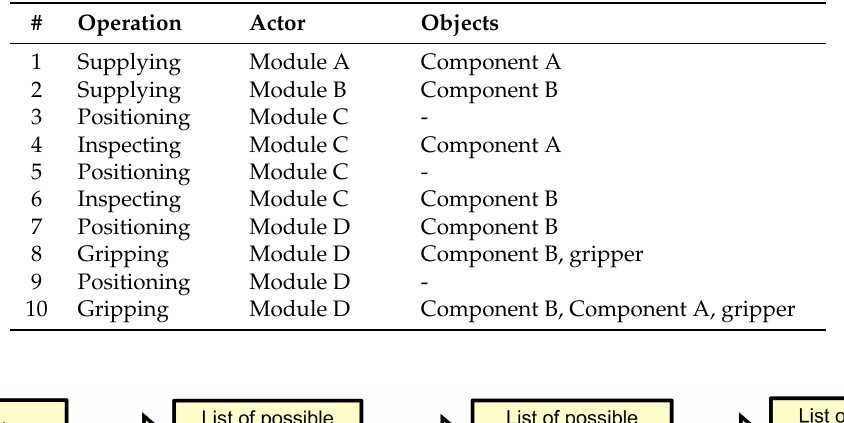
Table 3. Possible operation sequence for the procedure type “loading”. Component B is placed on Component A. Both components are supplied in the working area by two modules (A and B). A third module (C) inspects both components to gather information about their specific position in the working area. Therefore, Module C must be positioned at a prior defined rough position. Afterwards, the fourth module (D) can be positioned at B’s position. Module D can grip Component B, move it to the position of Component A, and release it there.